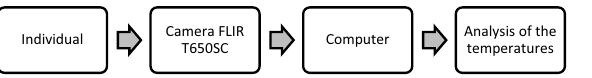
Figure 1. Setup of a thermal data measurement system.